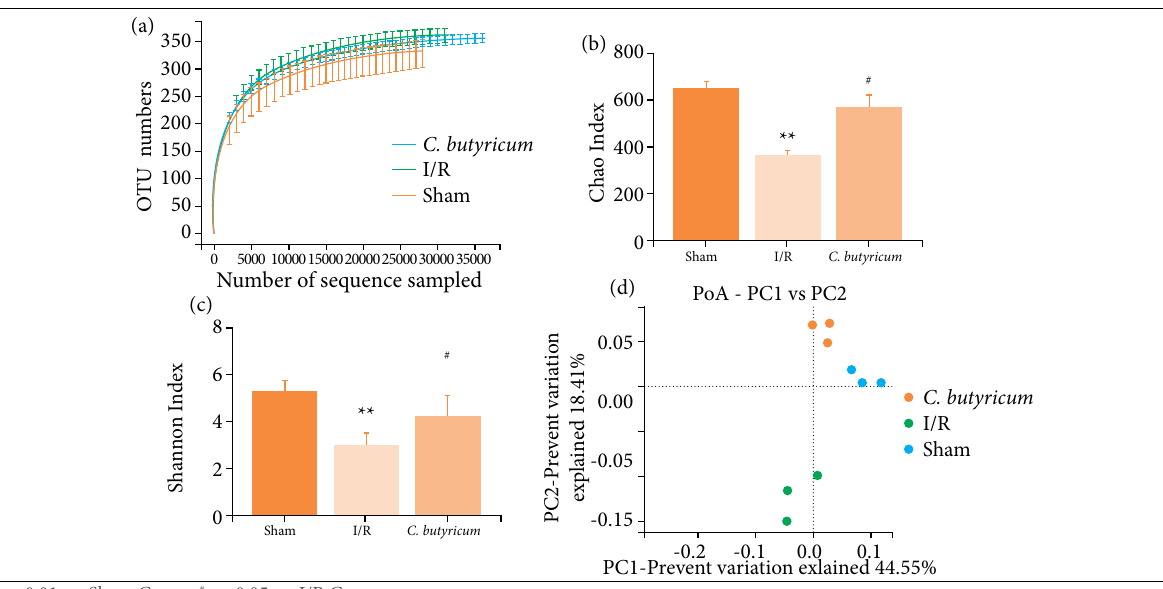
Figure 6 - (a) The dilution curves of different samples; (b) the effects of C. butyricum dietary supplement on the Chao index; (c) Shannon index; and (d) PCoA plot, of fecal microflora after reperfusion for 6